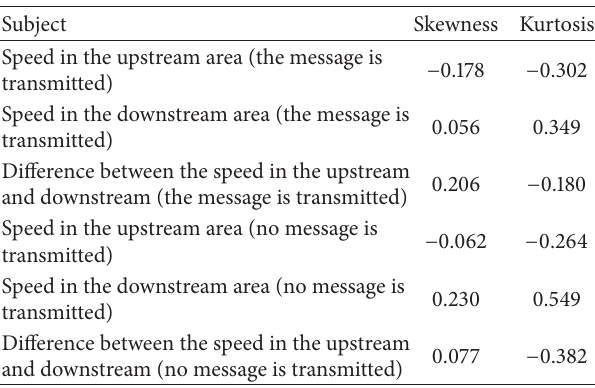
Table 5: Skewness and Kurtosis of speed